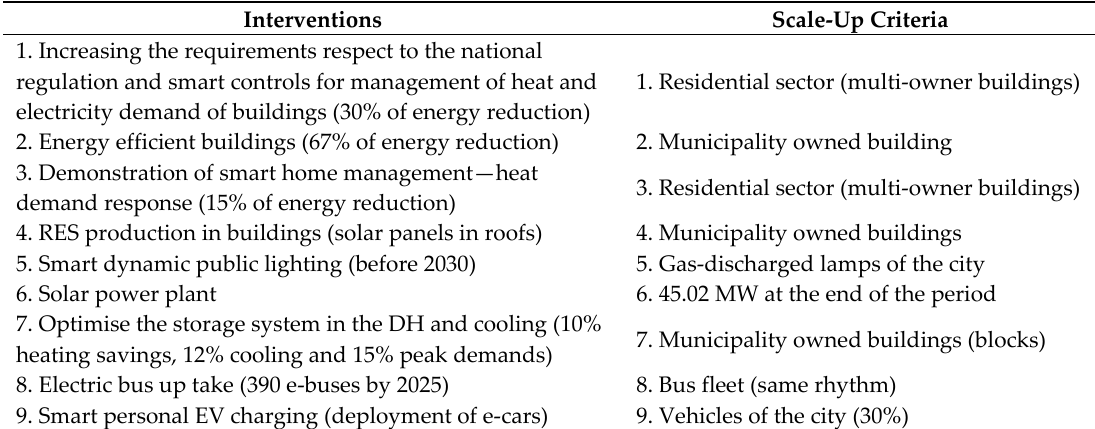
Table 2. Intervention selection and scale-up criteria for the intervention replication scenario.